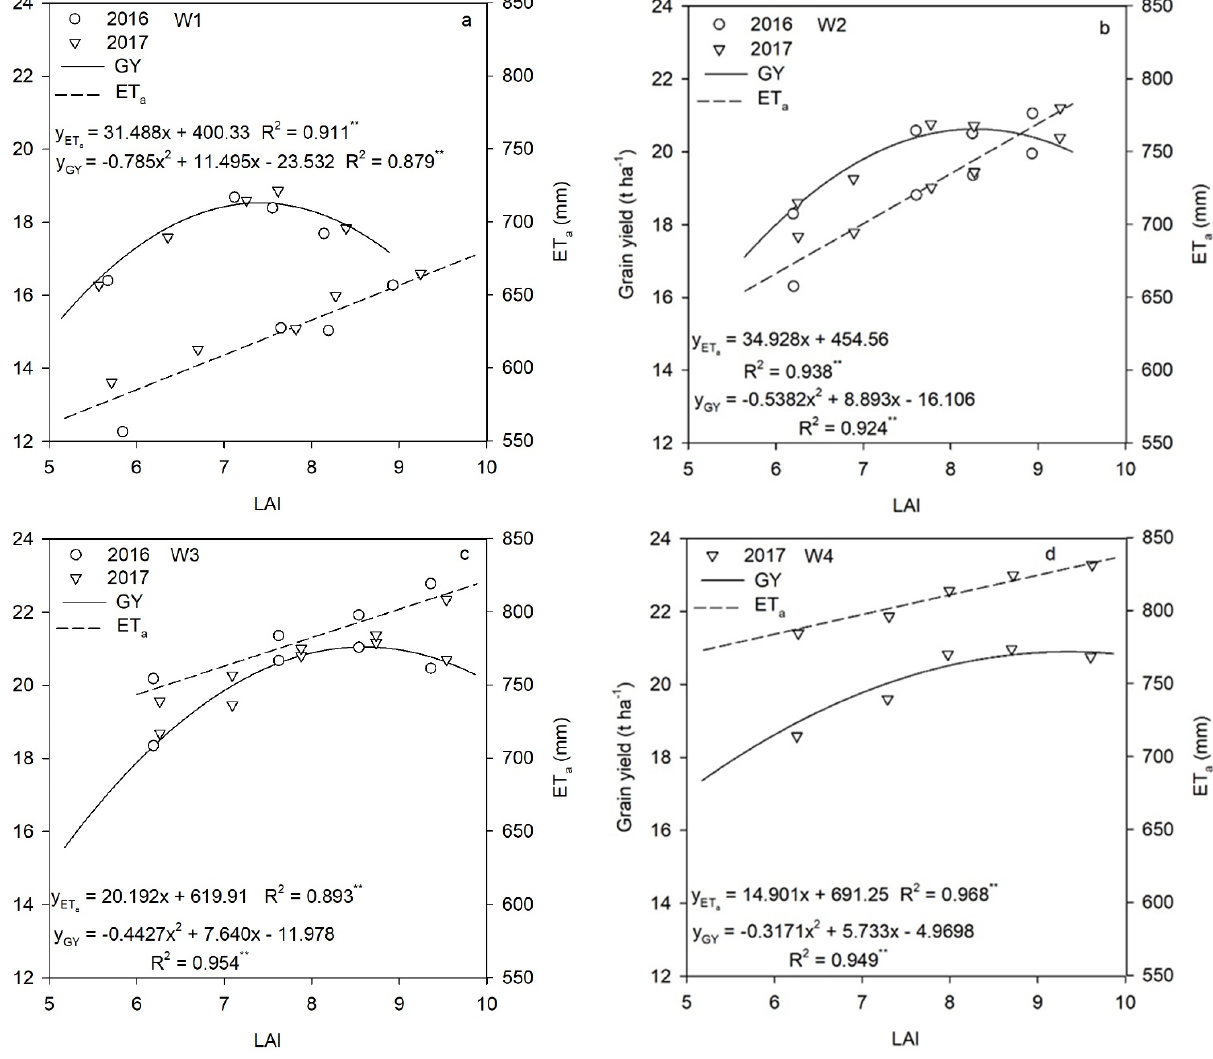
Figure 4. Relationships between LAI (silking), grain yield, and ET a at W1 ( a ), W2 ( b ), W3 ( c ), and W4 ( d ). GY, grain yield; ET a , evapotranspiration. ** denotes significance at the 0.01 level.